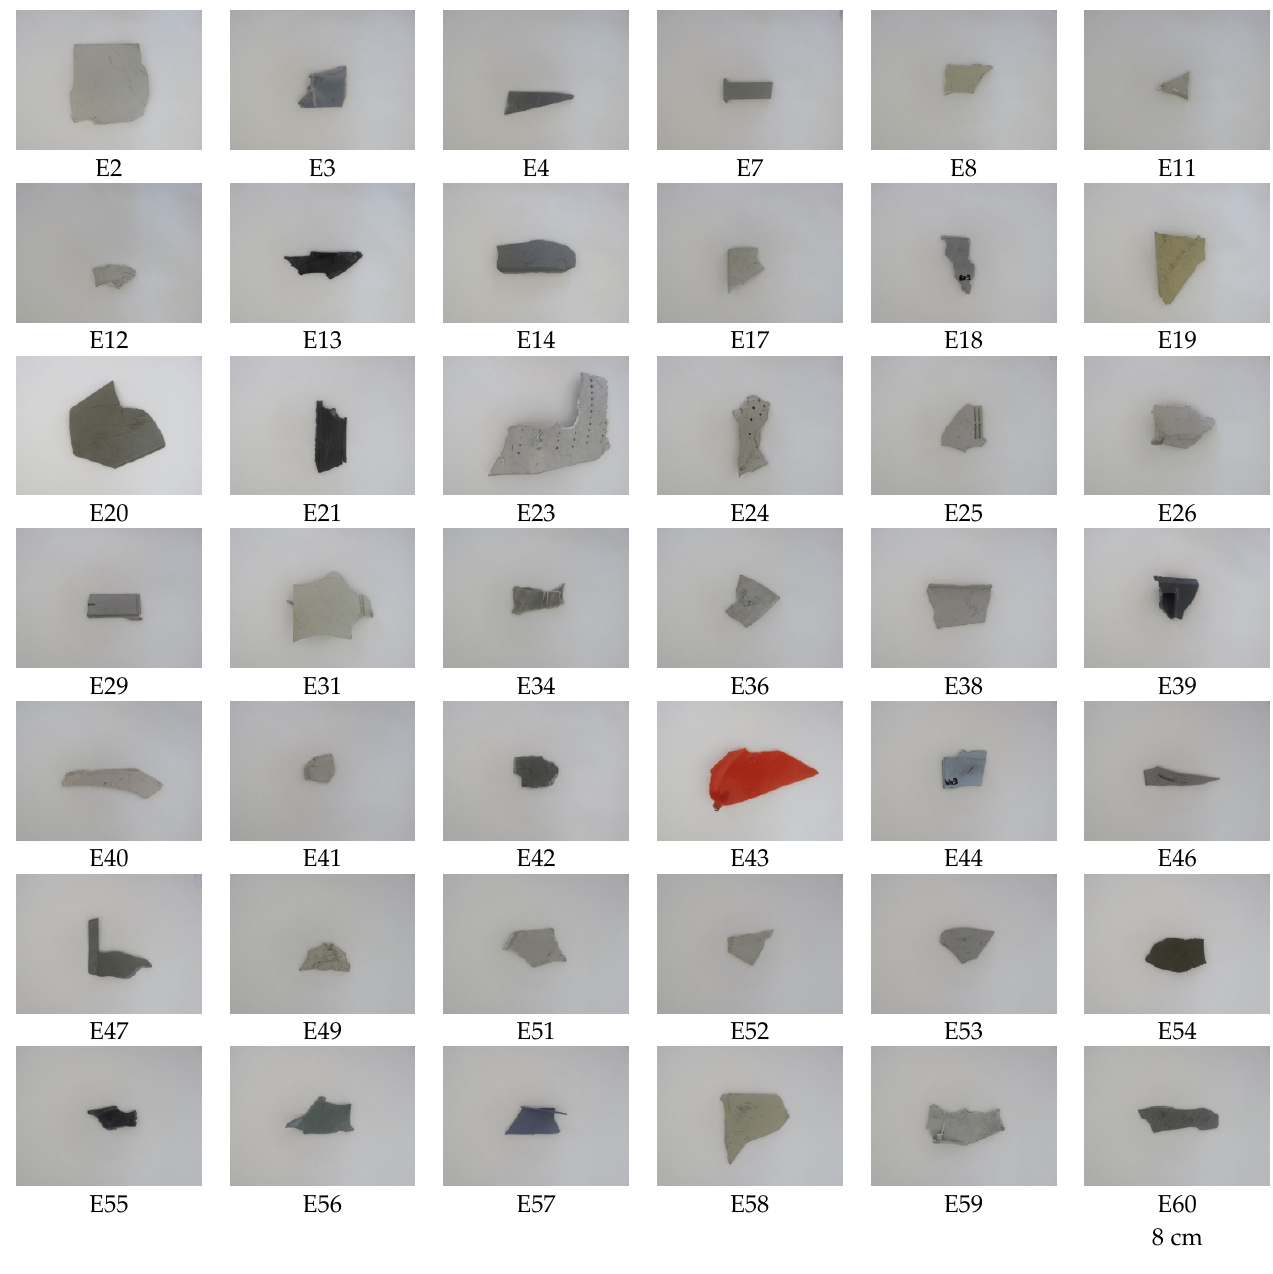
Figure 1. Analyzed e-waste plastic scraps. Labelling was assigned to identify each scrap preliminary characterized by XRF and then tested by SWIR